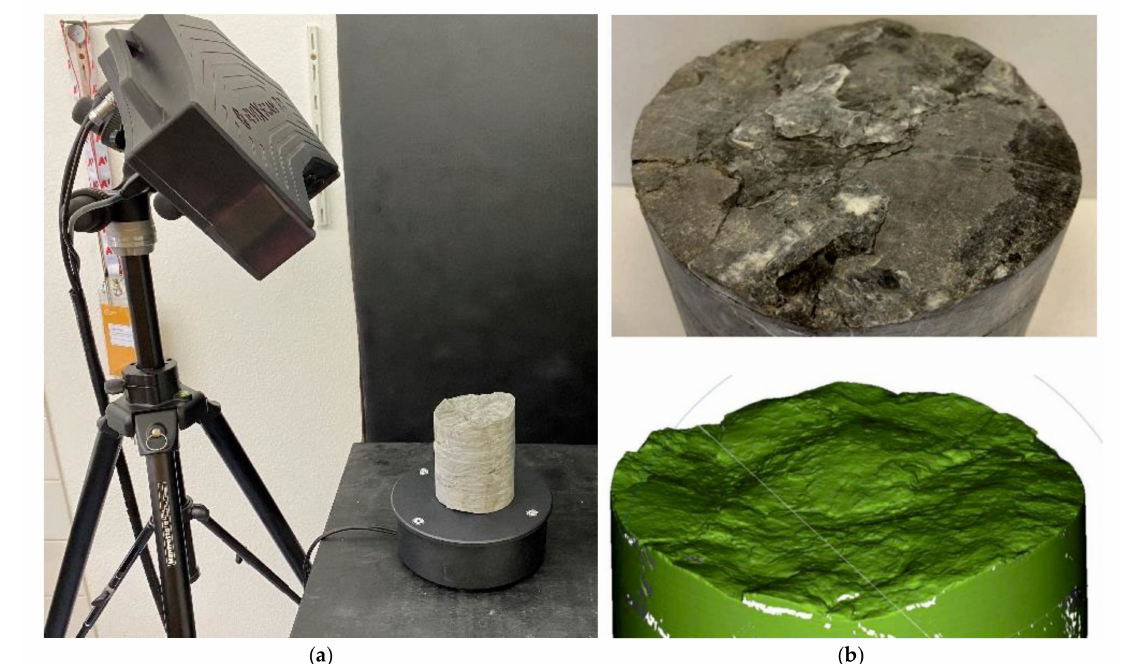
Figure 8. Scanning of the stone surface to determine the roughness: test configuration with the scanner ( a ), stone surface and resulting scanner image ( b